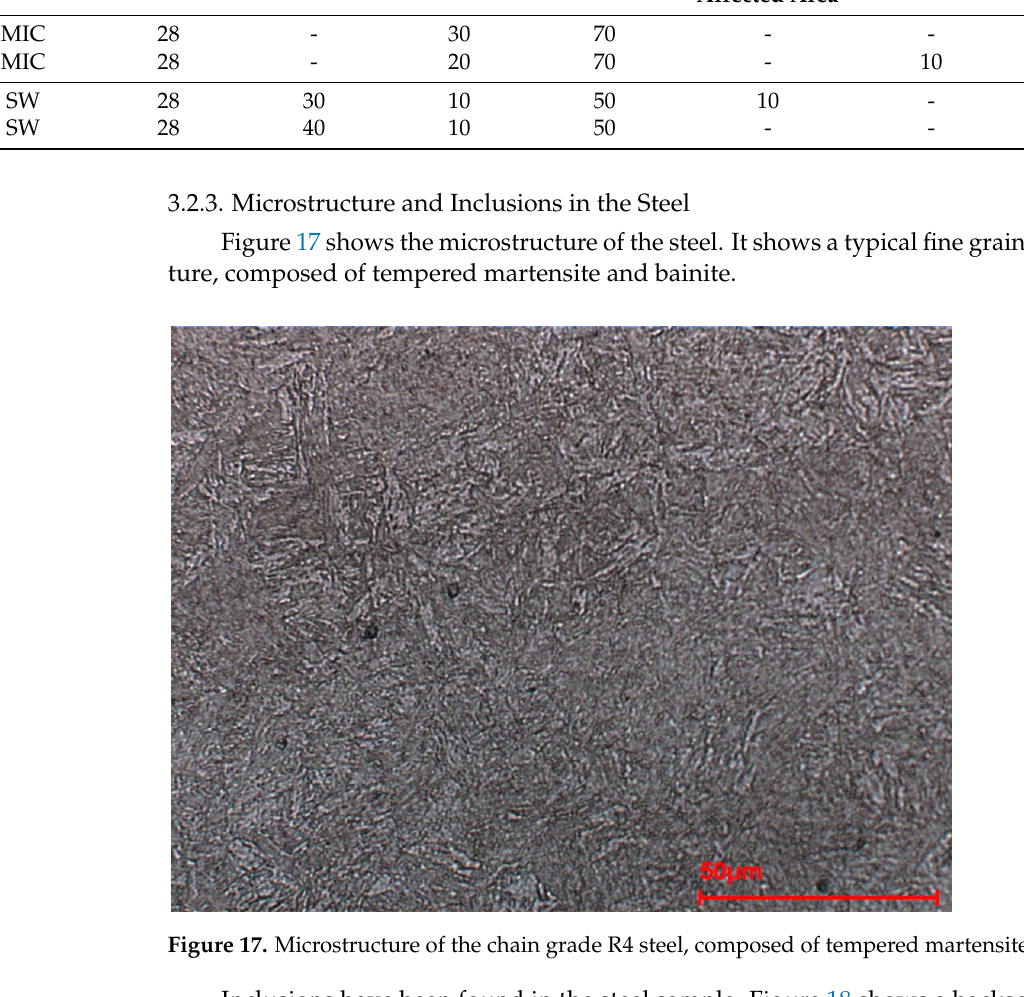
at a cross section (a) and EDS plots at a particle (b) and nearby area (c) for an exposed steel sample (S8). The composition analysed using EDS (see Table 8) indicates that the dark-grey 5 µ m in width. The elements detected at position (3) are related to the composition of the steel